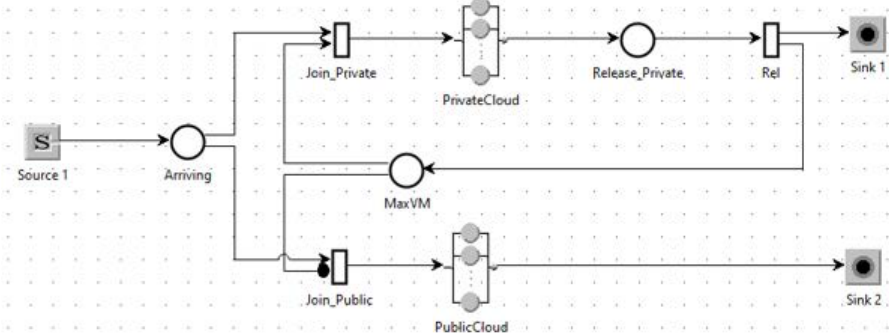
Figure 14. Layout of the model for the dynamic provisioning of VM in a Hybrid